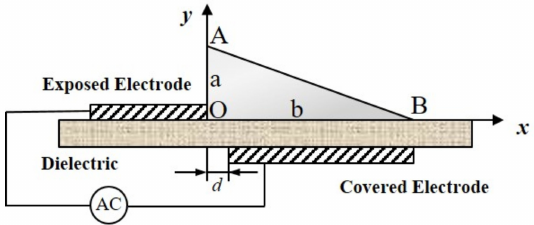
Figure 1. Schematic diagram of DBD plasma actuation